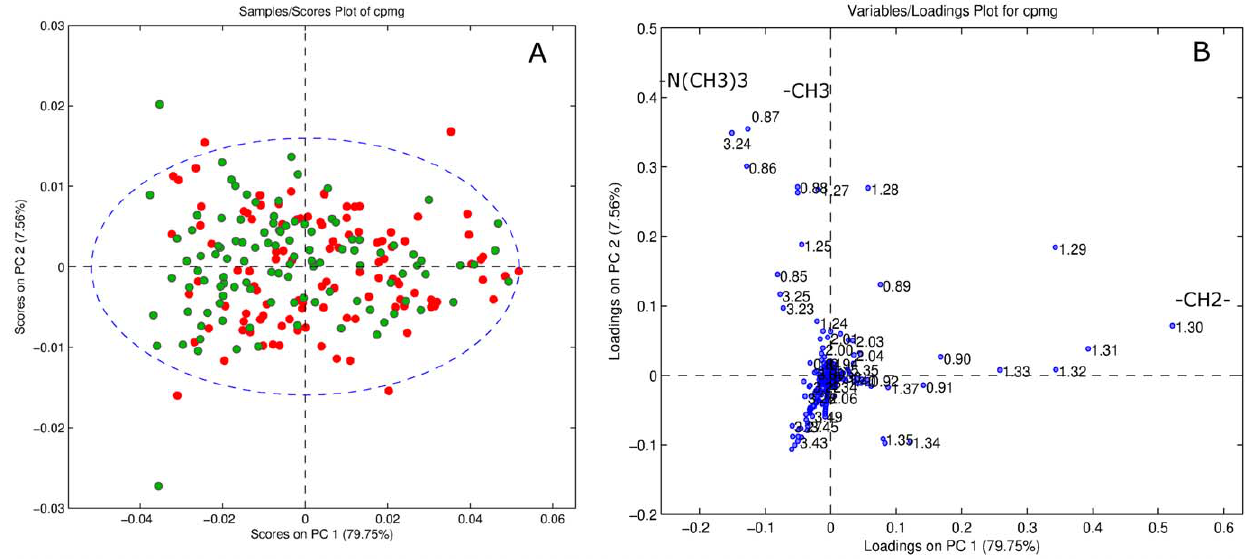
Figure 1. Principal Component Analysis (PCA) of the serum 1H MR spectra. (A) In the score plot, high VO 2max subjects are shown in green (higher density in upper left part) and low VO 2max subjects are shown in red. (B) The loadings plot visualizes the differences in metabolites between the two groups. The signals originating from within the core of the serum lipoprotein particles (-CH 3 at 0.86 ppm, -CH 2 - at 1.3 ppm) and choline- containing compounds (-N (CH 3 ) 3 + , at 3.24 ppm) are mainly responsible for the clustering. VO 2max : Maximal oxygen uptake.